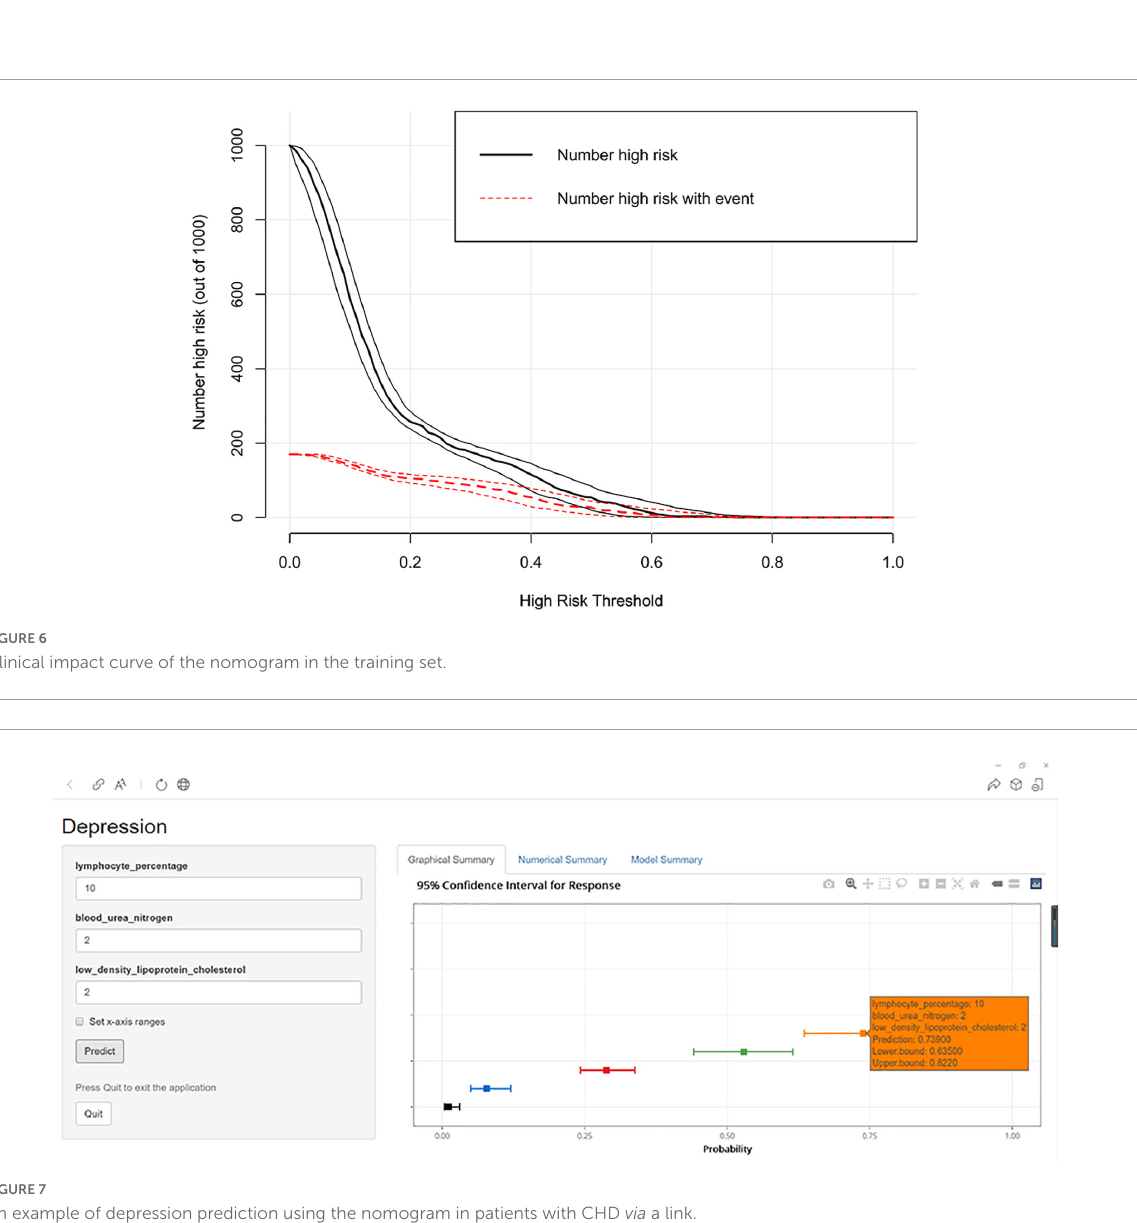
FIGURE7 An example of depression prediction using the nomogram in patients with CHD via a